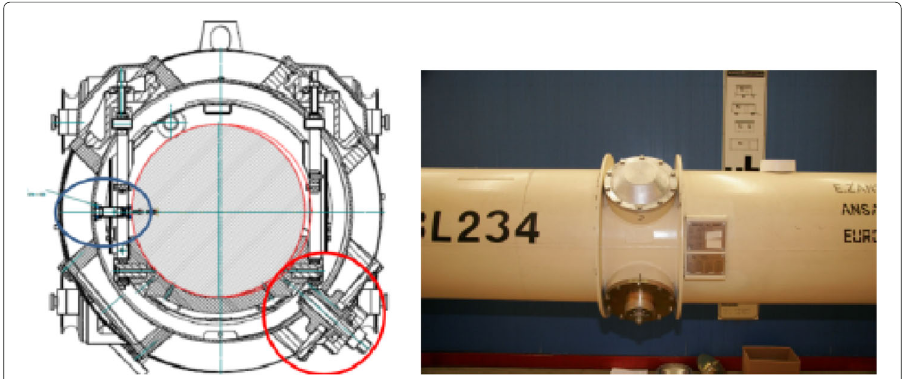
Fig. 10 Left: Cross section of the cryostat with an inserted outer pressure prop (blue) and a transportation fixture (red). A transportation fixture mounted into the vacuum vessel